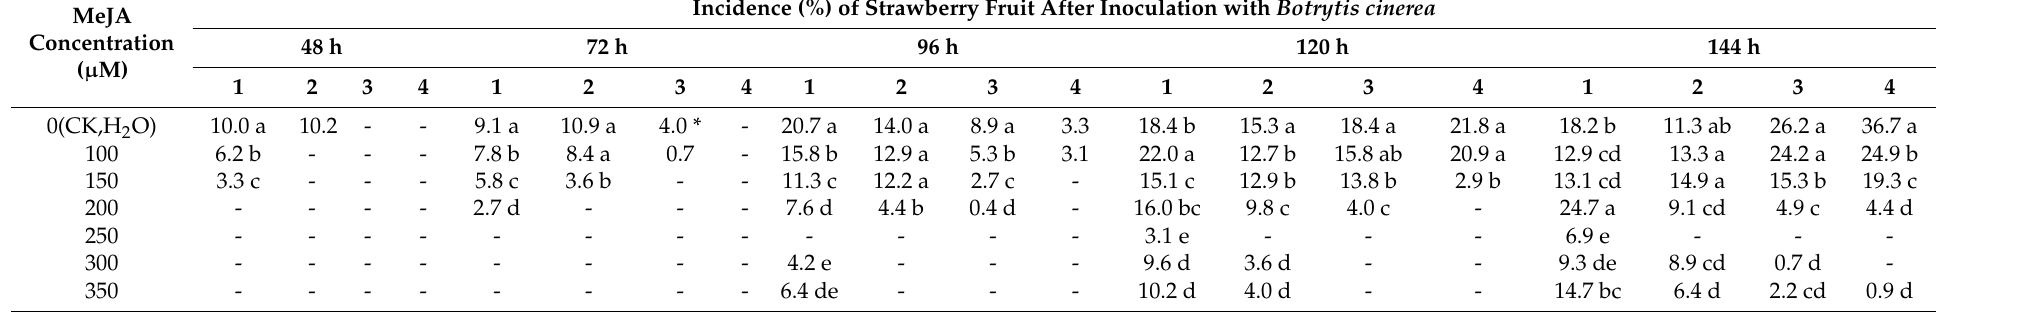
Table 2. Comparison of the fruit tissue damage levels of strawberry after inoculation with B. cinerea in different treatments with different concentrations of jasmonic acid. Level 1 does not include any damage. The experiment was repeated three times, and 60 fruits were used in each batch for each treatment.